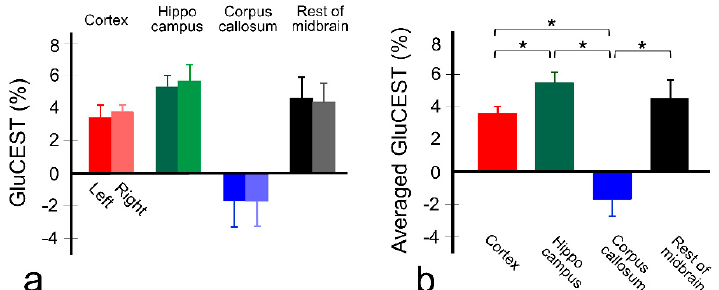
Figure 1. Regions of interest (ROIs) for quantitative analysis of chemical exchange saturation transfer (CEST) data ( a ). Z-spectra ( b , c ), and asymmetry curves ( d , e ) for each ROI in the left hemisphere and right hemisphere. All square data points indicate mean values ( n = 11), and error bars represent standard deviation. The Z-spectra and calculated CEST asymmetry curves in each ROI are shown in different colors Figure 2. Quantitative values of GluCEST signal in each brain region ( n = 11) in both hemispheres ( a ) (red, cortex; green, hippocampus; blue, corpus callosum; black, rest of midbrain). The black dotted line in and averaged values between both hemispheres ( b ). The bars represent mean values and error bars the asymmetry curve ( d , e ) represents glutamate CEST (GluCEST) signal at 3.0 ppm. represent standard deviations. * p < 0.0083 (=0.05/6) via a non-parametric Kruskal–Wallis H test with pairwise comparison using Wilcoxon rank-sum test.